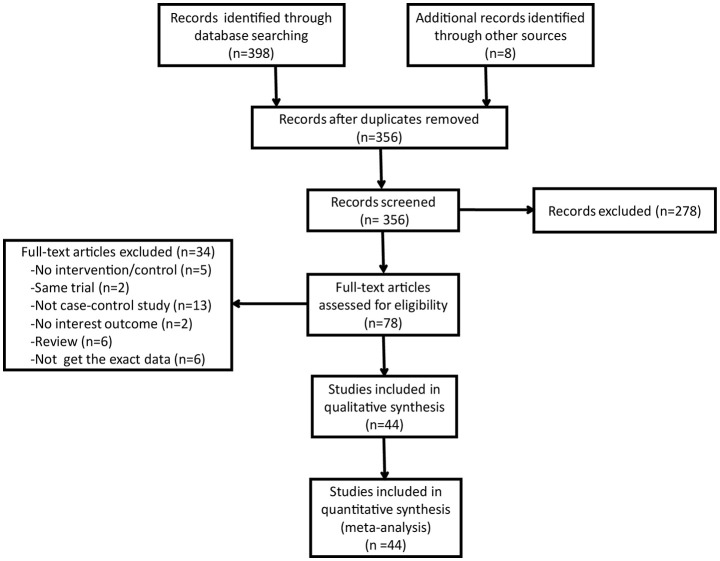
Study selection for systematic review.